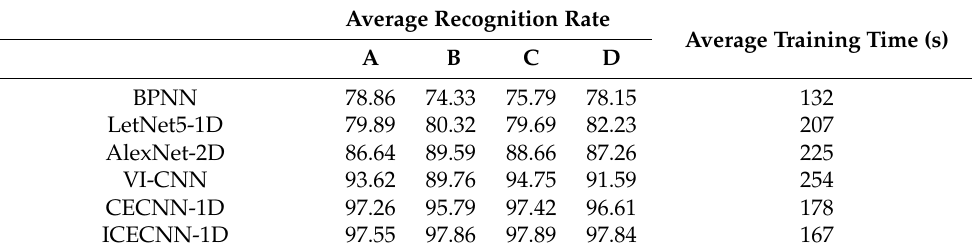
Table 7. Statistics of average recognition rate and average training